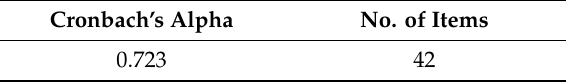
Table 2. Cronbach’s Alpha for the overall